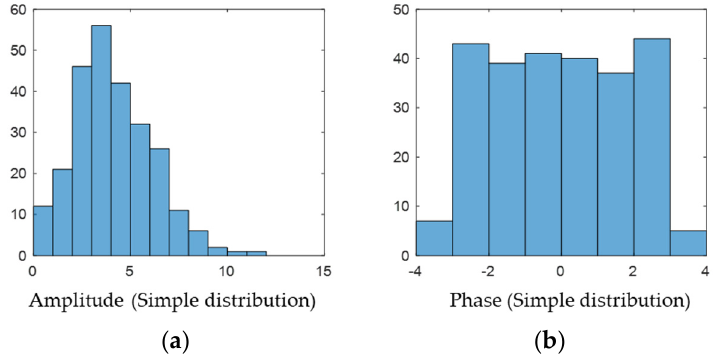
Figure 4. Histogram of the distribution of ( a ) amplitude and ( b ) phase.